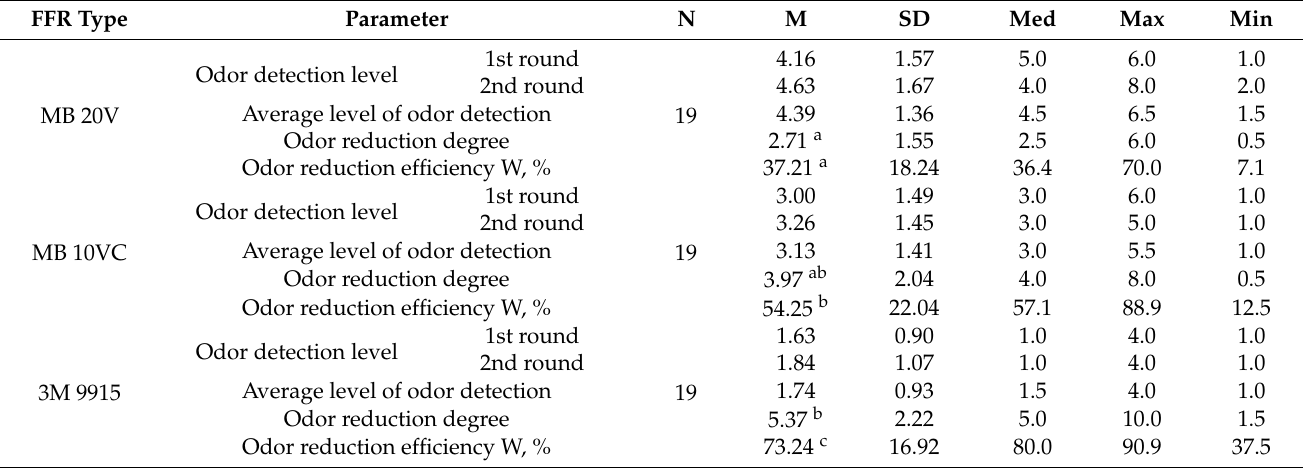
Table 3. The results of the odor reduction efficiency of the